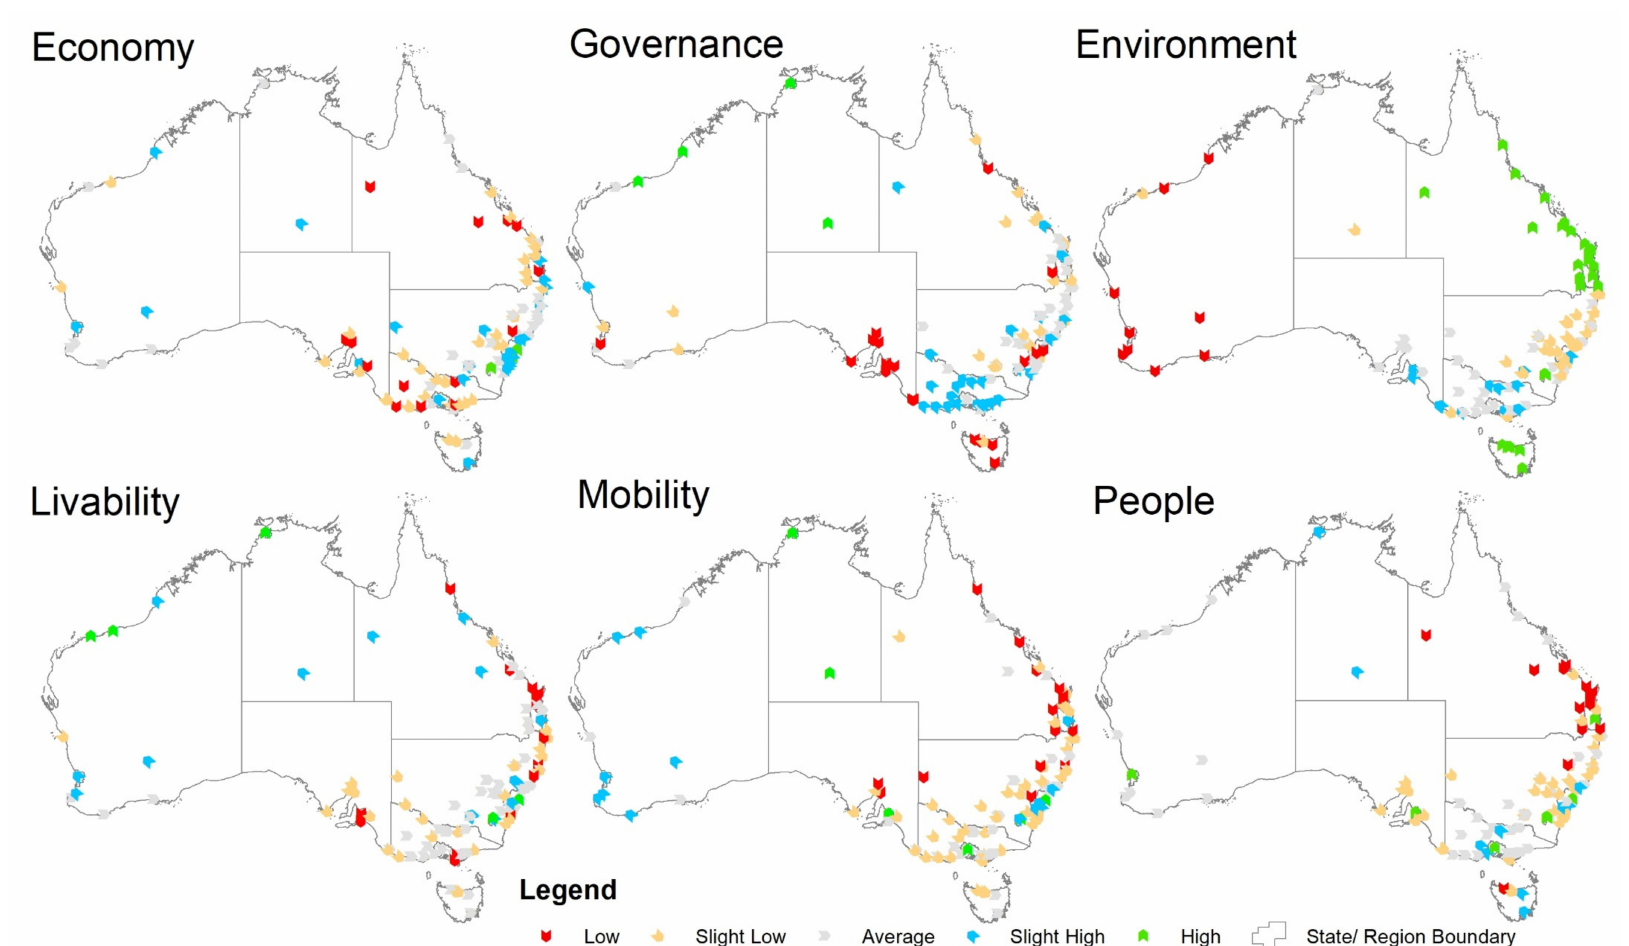
Figure 7. Smart cities performance in each